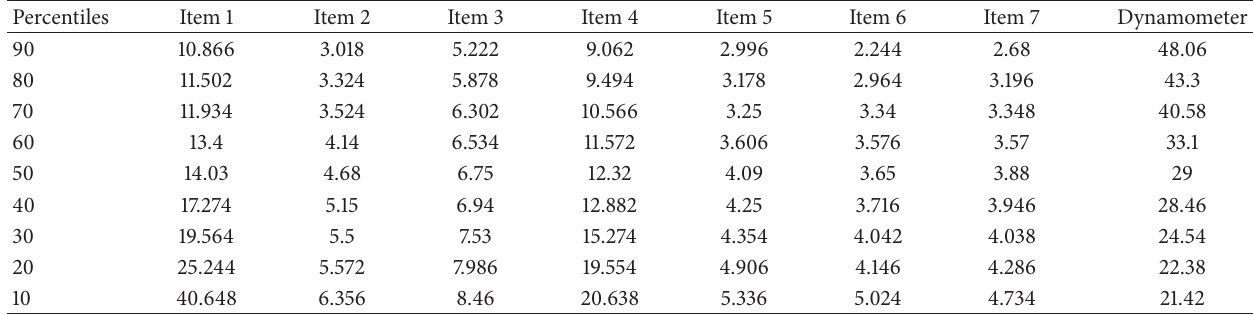
Table 15: 𝑛 = 15 , males, 6–19, dominant hand, educational instruction: attending elementary school.